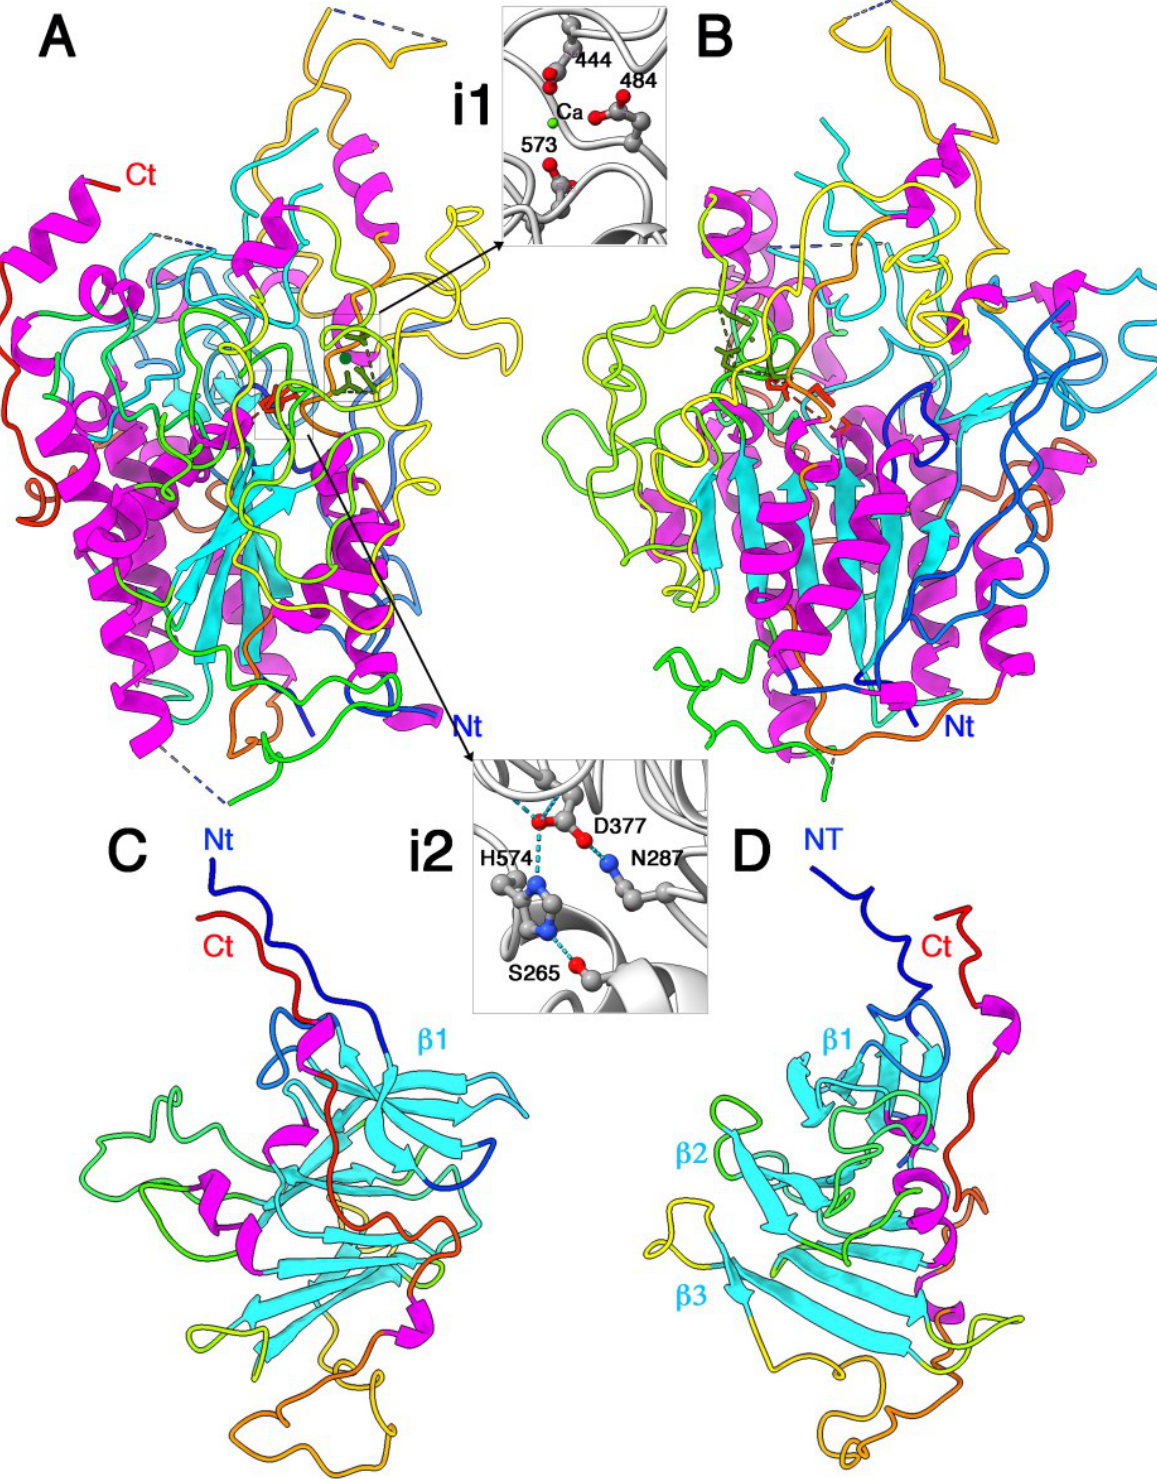
Figure 2. X-ray structure of Tle3 AIEC and Tli3 AIEC . ( A ) Structure of Tle3 AIEC ; the catalytic triad is colored red and the Ca 2+ cation in green. ( i1 ) The Ca 2+ ligands. ( i2 ) The catalytic triad. ( B ) Same view as ( A ) rotated 90 ◦ around a vertical axis. ( C ) Structure of Tli3. ( D ) Same view as ( D ) rotated 90 ◦ around a vertical axis. The three β -sheets are labeled β 1–3. ( A – D ) The protein backbones are rainbow colored. The helices are colored magenta and the β -strands are colored blue. The inset atoms arec colored red (oxygen), blue (nitrogen), grey (carbon) and green (calcium). The Tli3 AIEC immunity protein is predicted to be translated as a 274-residue long pro- tein, with 24 residues cleaved upon processing and acylated at the N-terminal cysteine residue of the mature form (Figure S2). A total of 30 – 33 residues at the N-terminus of the mature form, which may correspond to a linker, as well as 0 – 5 residues at the C-terminus, are not observed in the electron density map. The Tli3 AIEC structure possesses overall di- mensions of 60 × 45 × 45 Å . (Figure 2C,D). The core of Tli3 AIEC is assembled in three stacked β - sheets of 4, 3 and 4 β -strands, respectively, with topology of β 1 β 2 β 3 β 4 , β 6 β 7 β 8 , β 5 β 10 β 11 β 12 . A long loop of 17 residues is observed between strands β6 and β7 (residues 133 – 150). A large loop after strand β 12 is followed by a very long extended C-terminal segment that runs antiparallel to the extended N-terminus. The extremities of these segments point out- wards from the core. Dali returned several hits with small Z values (~6 – 6.4) and a rela- tively low number of residues aligned (~120). These hits cover many different functions